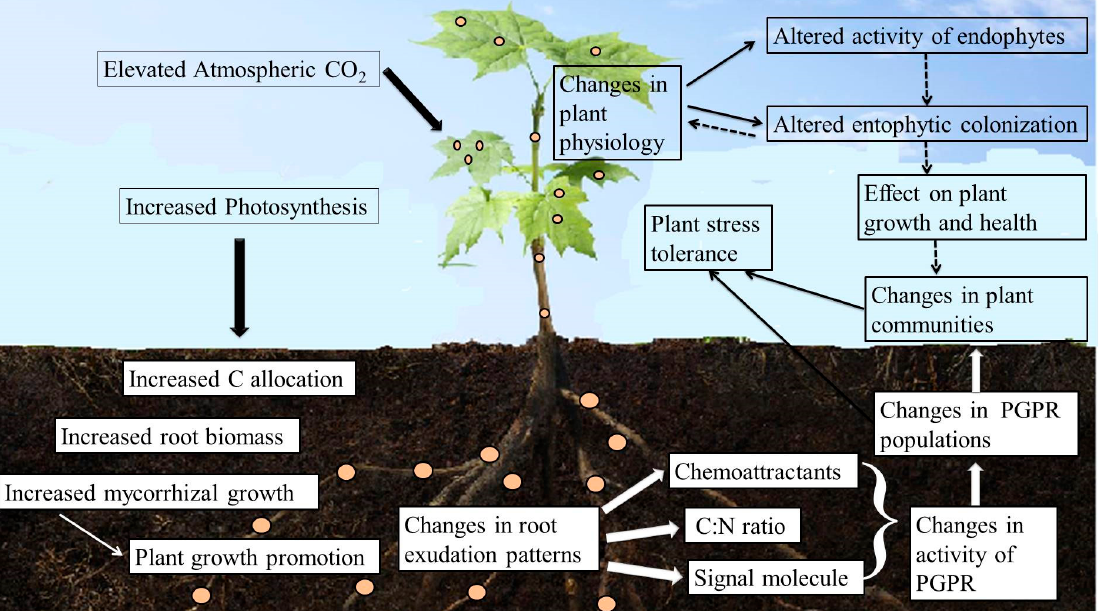
2 concentration on